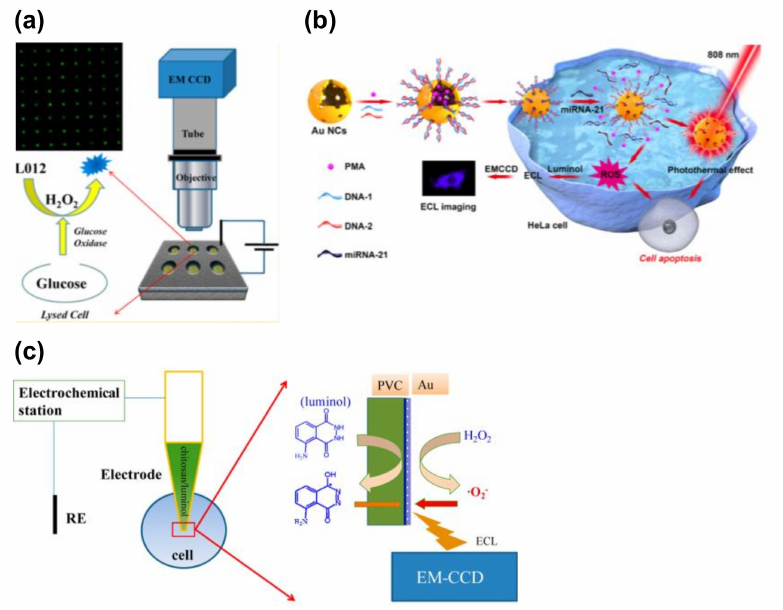
Figure 4. ECL detection of intracellular molecules. ( a ) ECL detection of intracellular glucose. Individual cells were trapped inside the microwells with an indium tin oxide (ITO) electrode. Cells were lysed to release glucose, and the glucose was reacted with glucose oxidase to produce H 2 O 2 . The H 2 O 2 was visualized using ECL imaging. Reproduced with permission from [52]. ( b ) ECL detection of intracellular microRNA (miRNA). Au nanoclusters (NCs) were introduced as a probe, and reactive oxygen species (ROS) were released after the miRNA recognition. The ROS were visualized using luminol at the fluorine-doped tin oxide (FTO) electrode. Reproduced with permission from [55]. ( c ) ECL detection of intracellular H 2 O 2 using a capillary electrode. Chitosan / luminol was filled with the tip. Intracellular H 2 O 2 was converted into the ECL signals. Reproduced with permission from